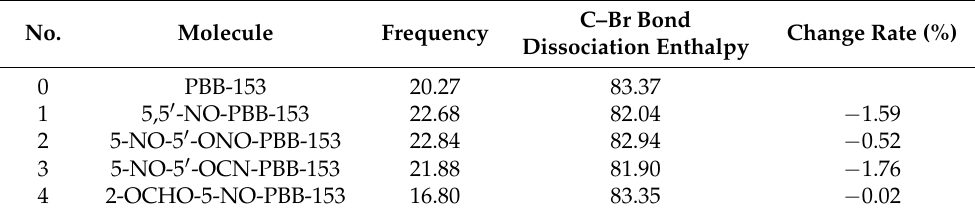
Table 5. Calculation of frequency and C–Br bond dissociation enthalpy before and after PBB-153